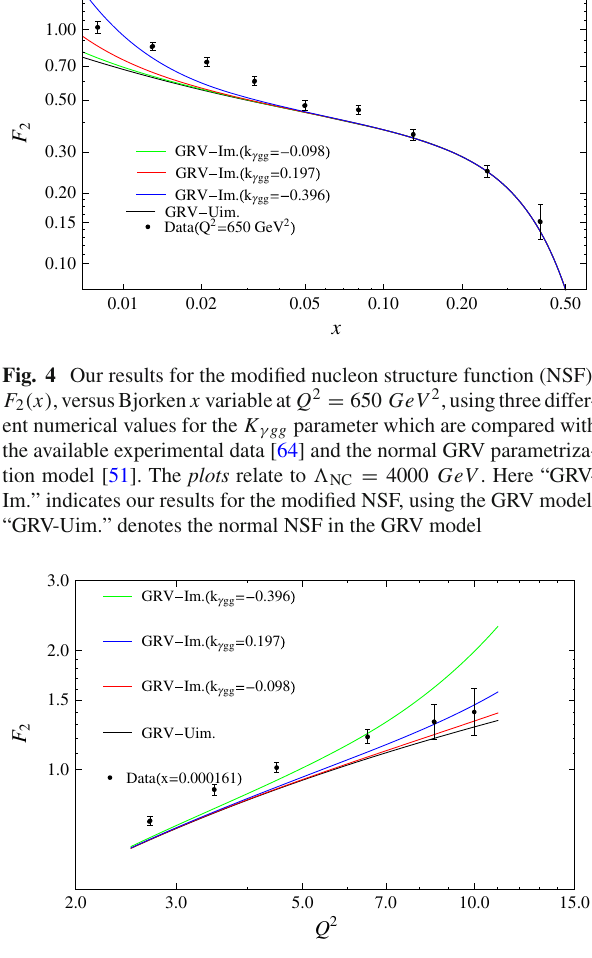
Fig. 5 Our results for the modified nucleon structure function (NSF) , F 2 ( x ) ,at x = 0 . 000161,versus Q 2 variable,usingthreedifferentvalues of theK γ gg parameter, which are compared with the available experi- mental data [64] and the normal GRV parametrization model [51]. The plots relate to (cid:4) NC = 1300 GeV. Here “GRV-Im.” indicates our results for the modified NSF, using GRV model. The “GRV-Uim.” denotes the normal NSF in the GRV